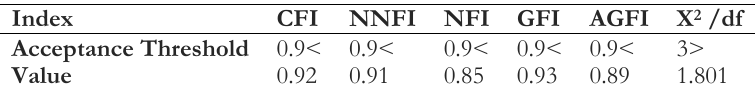
Table 7. Fitness index.